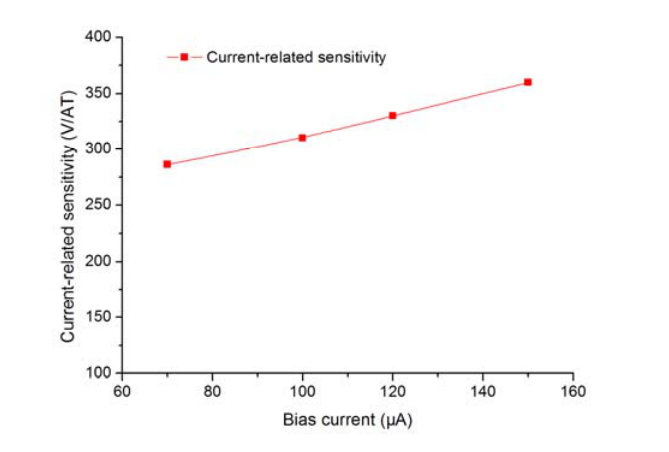
Figure 10. Measurement of the variation of the current-related sensitivity with the biasing current.